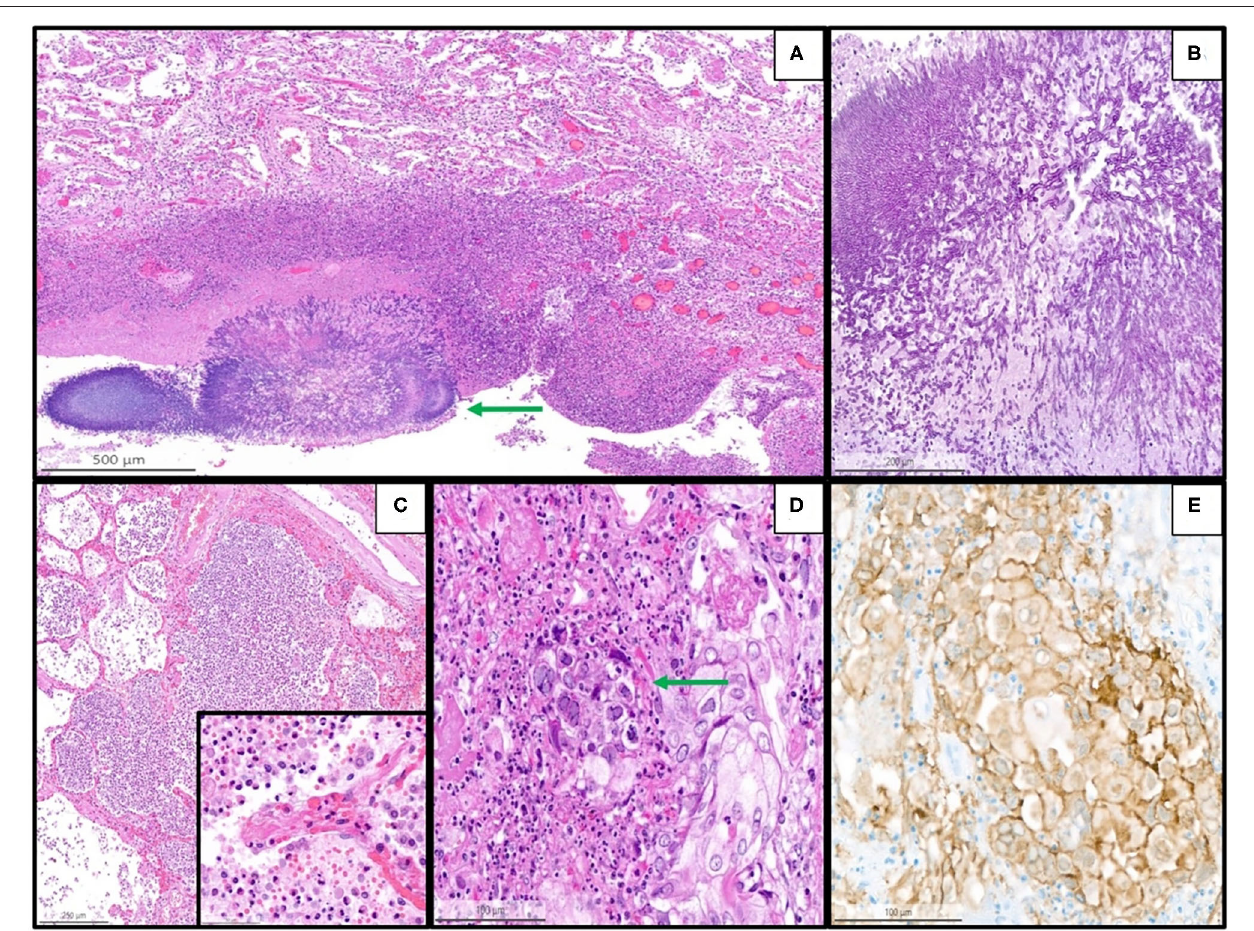
FIGURE 4 | Representative histopathological findings in autopsies from the second wave, illustrating examples of coinfections in the lung of the patients with coronavirus disease 2019 (COVID-19). (A) Lung tissue with aspergillosis (arrow) and surrounding acute inflammation (H&E, magnification 10 x). (B) Details of image A showing the typical hyphae of Aspergillus spp . (PAS, magnification 30 x). (C) Acute (bacterial) bronchopneumonia showing granulocytic exudate in the alveolar space and destruction of alveolar septa (H&E, magnification 6 x); the inset illustrates granulocytic inflammation with destruction of a septum (magnification 50 x). (D) Herpes simplex pneumonia exhibiting typical herpes-associated nuclear changes (molding, multinucleation, margination of chromatin, see the arrow) (H&E, magnification 25 x). (E) Immunohistochemistry for Herpes simplex virus demonstrates a granular cytoplasmic and nuclear positivity along with the typical nuclear changes (magnification 25